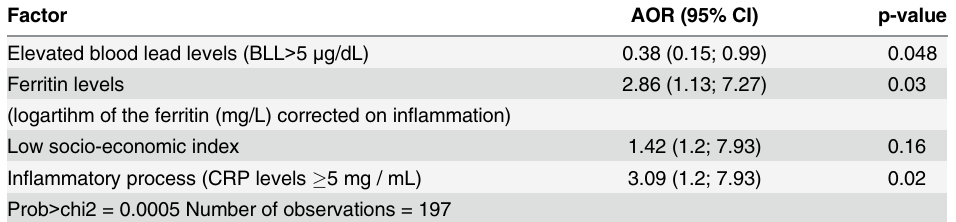
Table 5. Logistic regression on the possibility of having a positive blood smear at 12 months.